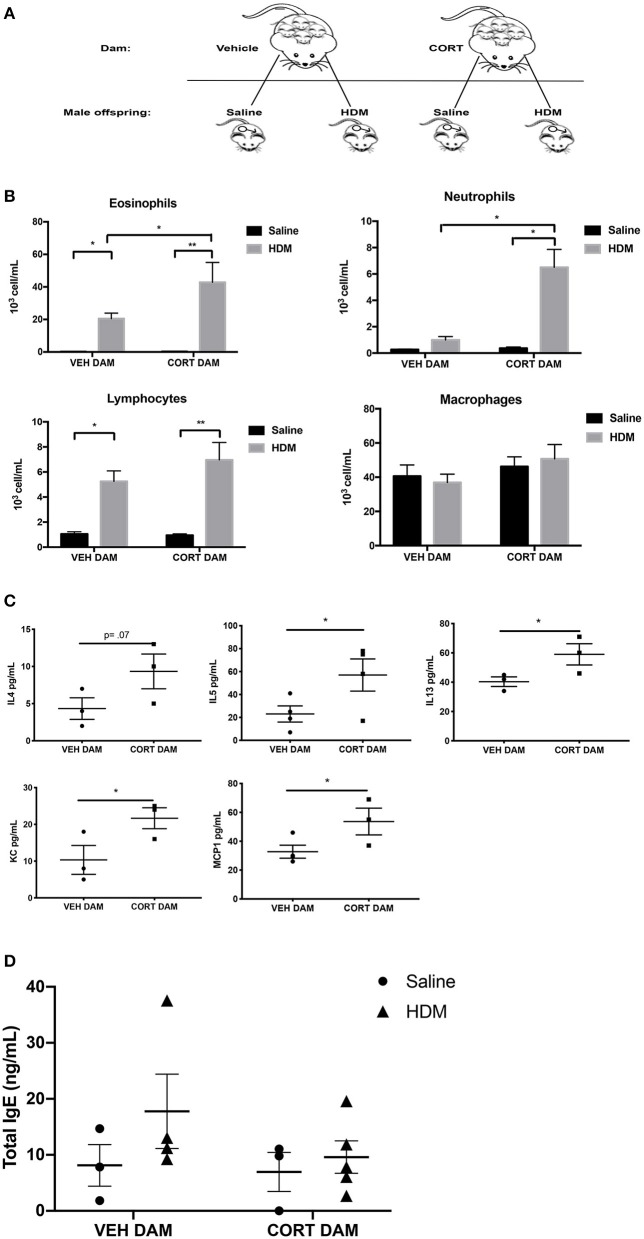
Pulmonary immune cells, cytokines, and total serum IgE in male offspring from vehicle and CORT-treated dams. (A) Schematic representation of dam and offspring treatments. Pregnant females received corticosterone (CORT) or vehicle in drinking water at E12.5 until the end of pregnancy. Male offspring from CORT and vehicle treated dams were treated with saline or HDM consisting of 135 μg of the major allergen Der p 1. (B) Immune cells were quantified, total eosinophils (*p = 0.02, **p < 0.0001), neutrophils (*p < 0.0001), lymphocytes (*p = 0.0009, **p < 0.0001), and alveolar macrophages in BAL of male offspring from vehicle or CORT-treated dams, treated with HDM or saline (n = 6–8). (C) Cytokine and chemokine concentrations in BALF from HDM-treated male offspring from vehicle and CORT-treated dams. Interleukin-4 (IL-4), interleukin-5 (IL-5), interleukin-13 (IL-13), keratinocyte chemoattractant (KC), and monocyte chemoattractant protein-1 (MCP-1) concentrations are reported as pg/mL in BALF. (D) Total IgE in serum of male offspring treated with saline (circle) and HDM (triangle), with concentrations reported as ng/mL (*p < 0.05, n = 3–5).